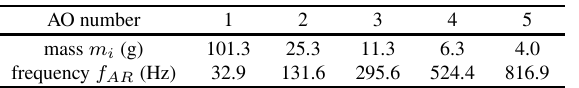
Table 2 Characteristics of the pinned-free beam AO model